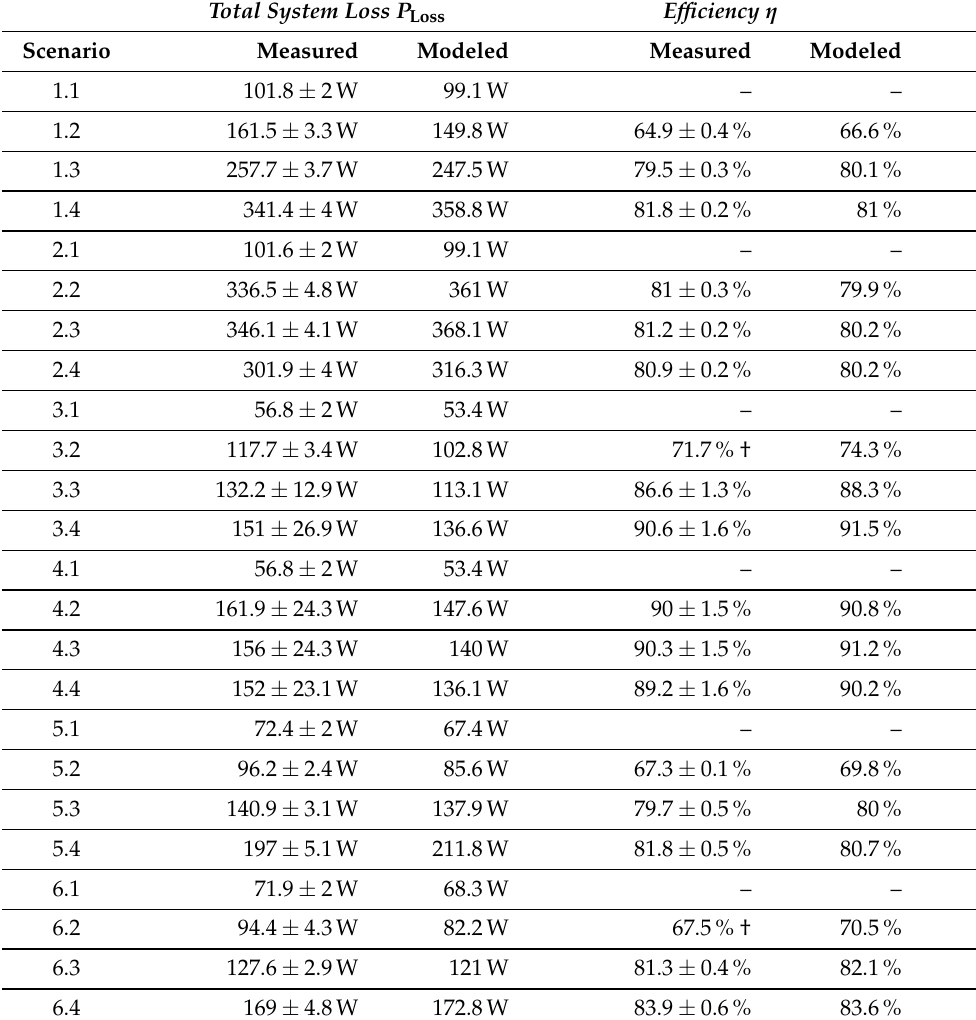
Table A4. Measured and modeled values for total system loss and efficiency.